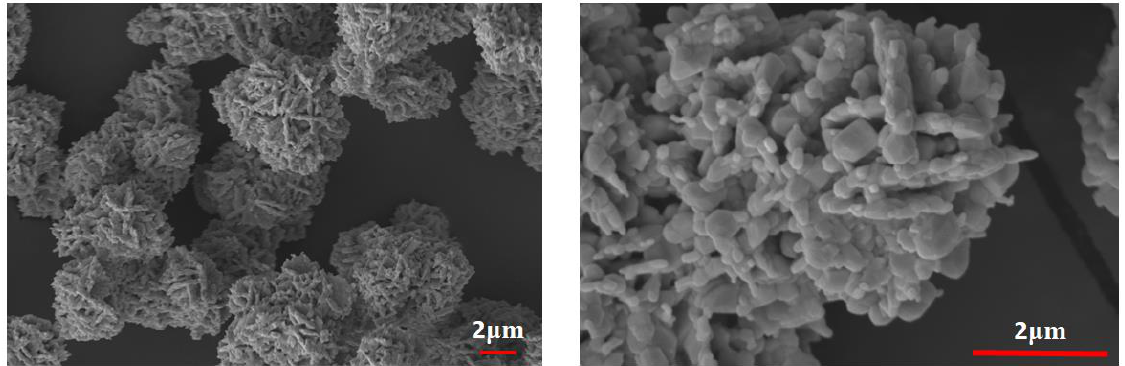
Figure 2. SEM images of the hydrothermally synthesised WO 3 nanofiller.